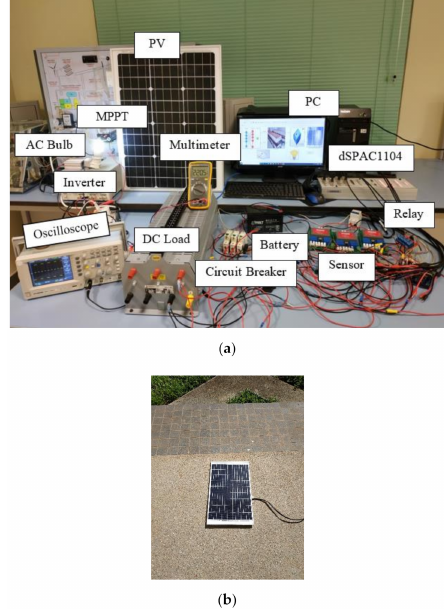
Figure 6. ( a ) Experimental setup of the developed hardware model; ( b ) Photovoltaic (PV) panel installation in the vicinity of the laboratory hardware model.